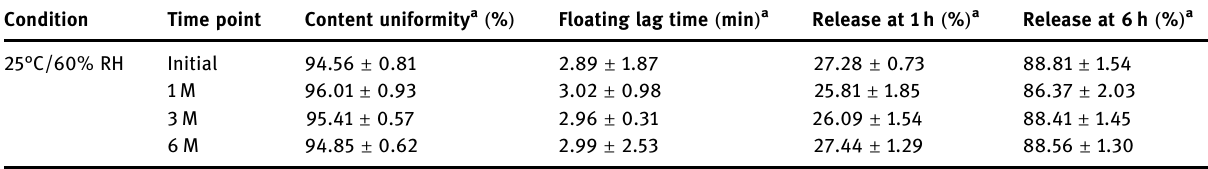
Table 6: Responses of the optimized formulation on real time stability studies ( 25°C, 60% RH ) Condition